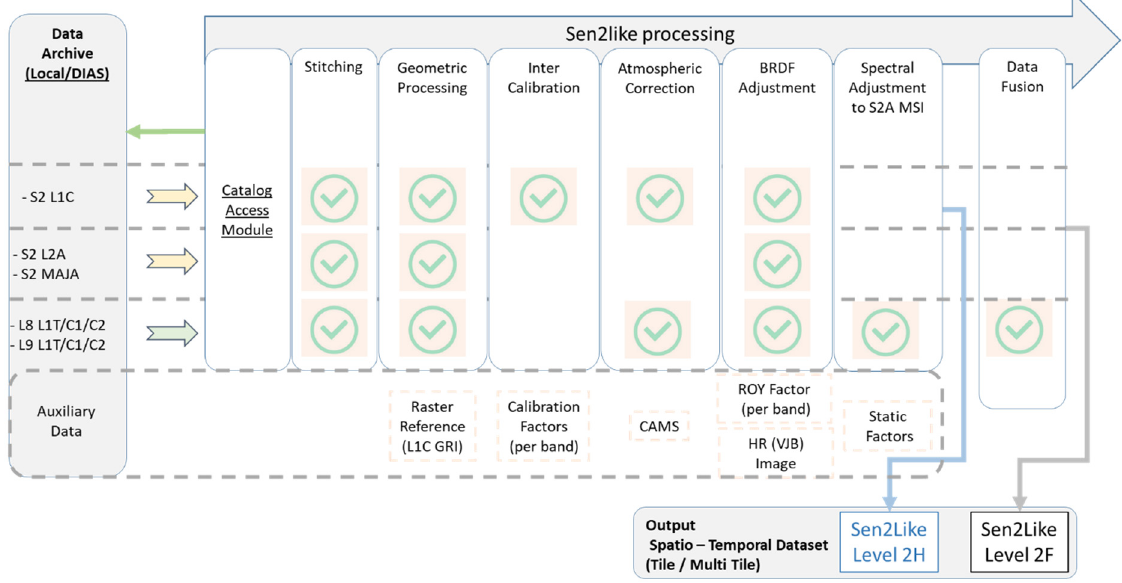
Figure 1. The Sen2Like processing framework for generating L2H and L2F products .